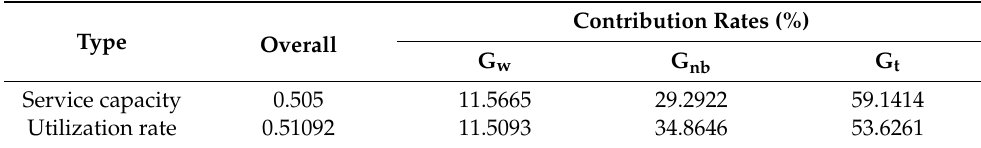
Table 3. The Dagum Gini coefficient and its decomposition results.